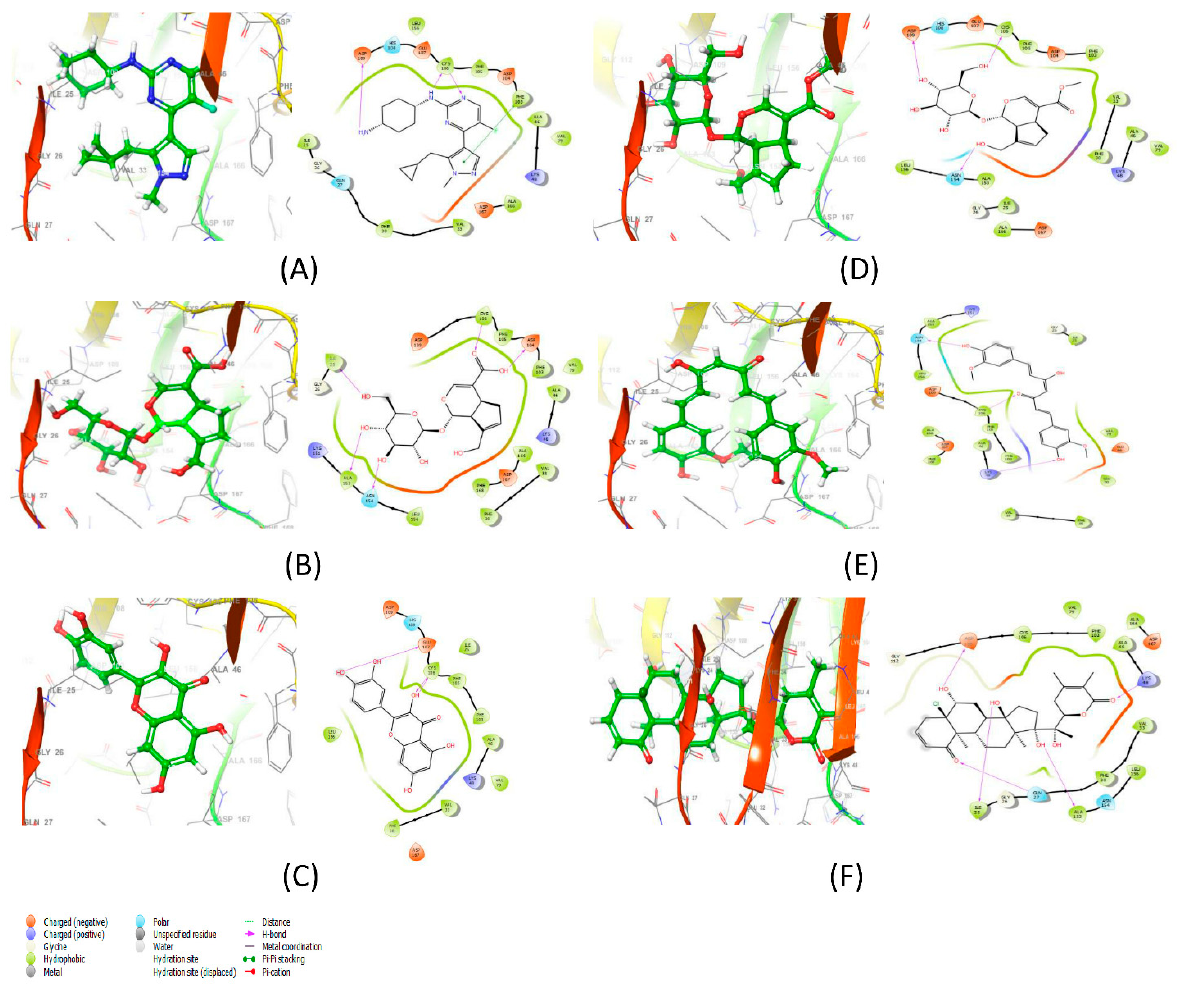
Figure 3. Interactions of ( A ) 6GZH-LCI ( B ) 6GZH-Geniposidic Acid, ( C ) 6GZH-Quercetin, ( D ) 6GZH-Geniposide, ( E ) 6GZH-Curcumin, and ( F ) 6GZH-Withanolide C Complex. Interaction through H-bonds between the docked complexes was calculated, such as the 6GZH-LCI complex (CYS106, ASP109), 6GZH-geniposidic acid complex (ILE25, ALA153, ASN154, ASP104, and CYS106), 6GZH-quercetin complex (CYS106, GLU107), 6GZH-geniposide complex (ASN154, CYS106, and ASP109), 6GZH-curcumin complex (LYS48, CYS106, and ASN154), and 6GZH-withanolide C complex (ILE25, GLN27, ALA153, LYS48, and ASP109). Moreover, the non-bonding interactions of the 6GZH-LCI complex (polar: GLN27, HIS108; hydrophobic: ILE25, PHE30, ALA166, VAL79, ALA46, PHE103, PHE105, CYS106, and LEU156; negative charged: ASP167, ASP104, GLU107, and ASP109; positive charged: LYS48), 6GZH-geniposidic acid complex (hydrophobic: ALA153, LEU156, PHE30, VAL33, PHE168, ALA166, ALA46, VAL79, PHE103, and PHE105; negative charged: ASP167, ASP109; positive charged: LYS151, LYS48), 6GZH-quercetin complex (polar: HIS108; hydrophobic: LEU156, PHE30, VAL33, VAL79, ALA46, PHE103, PHE105, and ILE25; negative charged: ASP167, GLU107, and ASP109; positive charged: LYS48), 6GZH-geniposide complex (polar: HIS108; hydrophobic LEU156, ALA25, ALA166, PHE30, VAL33, ALA46, VAL79, PHE103, and PHE105; negative charged: ASP167, ASP104, and GLU107; positive charged: LYS48), 6GZH-curcumin complex (hydrophobic: ALA166, PHE168, VAL33, PHE30, ALA46, PHE103, PHE105, CYS106, LEU156, ILE25, VAL79, and LEU70; negative charged: ASP109, ASP167, and GLU66; positive charged: LYS151), and 6GZH-withanolide C complex (polar: ASN154, hydrophobic: PHE30, VAL33, LEU156, ALA46, ALA166, PHE103, CYS106, and VAL79; negative charged: ASP167) were